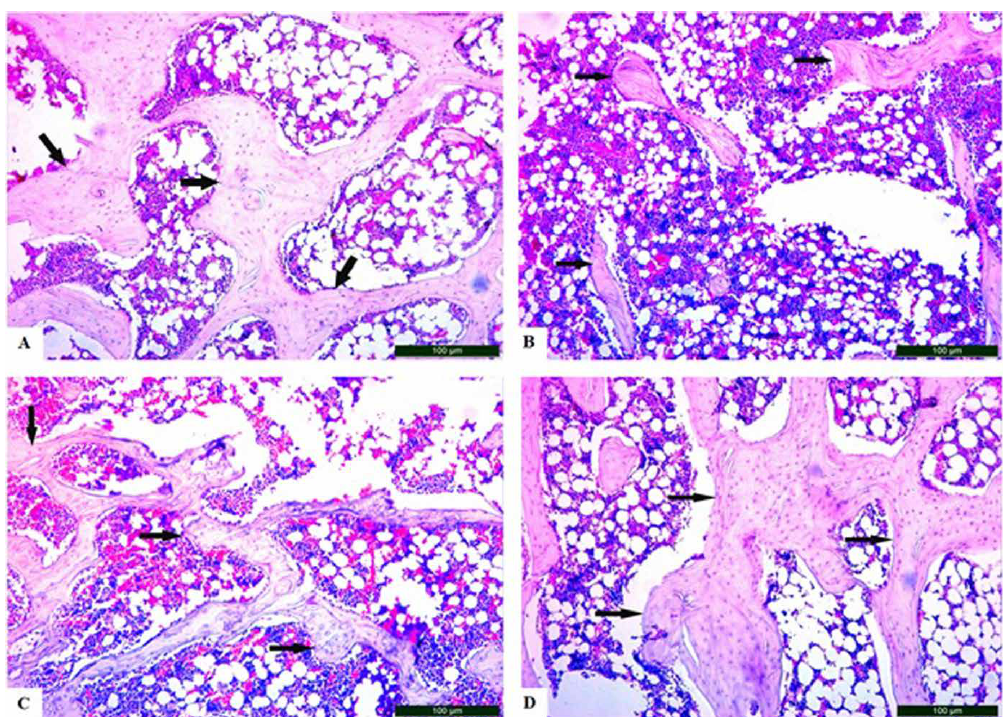
FIGURE 4 – Images showing the right femur epiphyseal bone width in rats with ovariectomy-induced osteoporosis. A: Control group, B: OVX group, C: OVX+zaprinast group and D: OVX+avanafil group. The area or distance between the two arrows indicates the epiphyseal area (bone growth plaque). Scale bar: 50